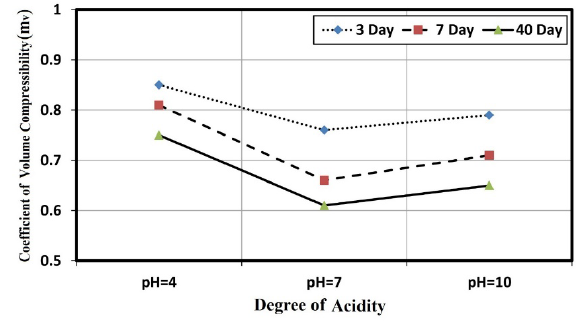
Figure 9: Failure strain of nonstabilized samples in various environments in terms of acidity.